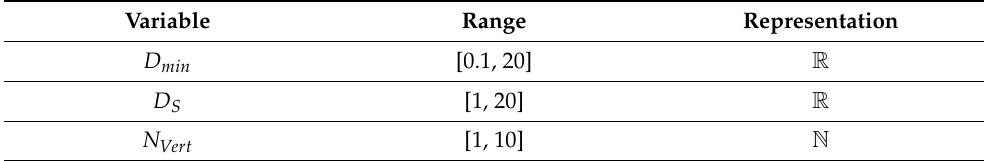
Table 2. Parameters used to create the initial